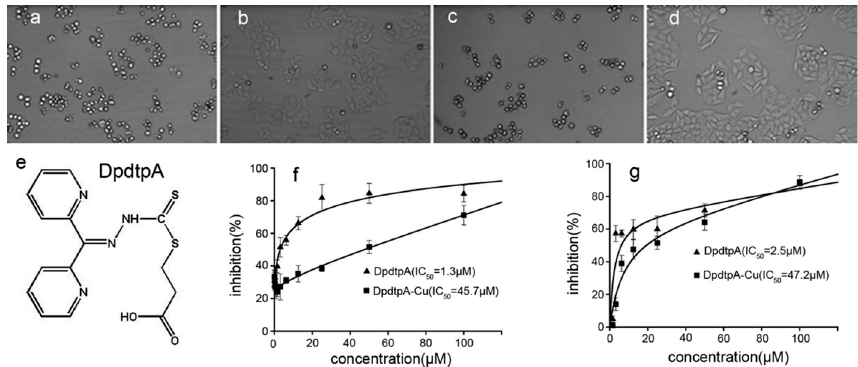
Figure 2. The chemical structures of DpdtpA and the proliferation inhibition assay. The effect of